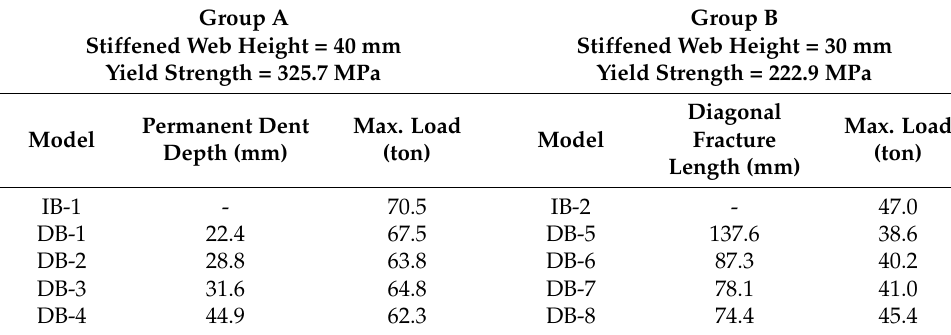
Table 5. The maximum applied load of each model.